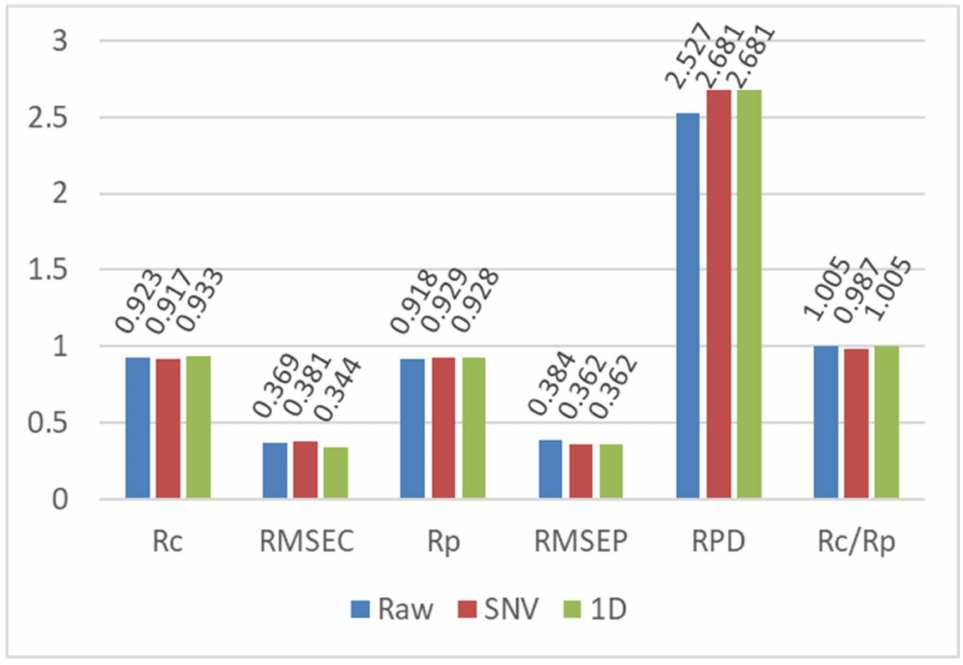
Figure 3. Results of PLSR prediction models for the fat content based on the raw spectra and spectra preprocessed by SNV and